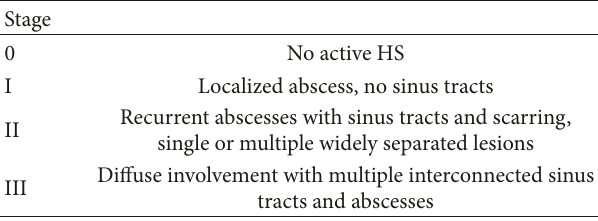
Table 1: Hurley staging